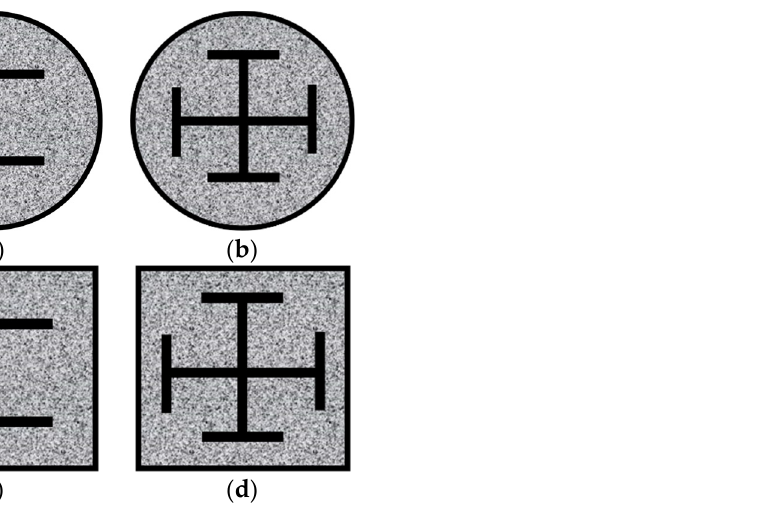
Figure 1. Section type of SRCFST: ( a ) Circular-cased I section; ( b ) Circular-cased crossed section; ( c ) Square-cased I section; ( d ) Square-cased crossed section.